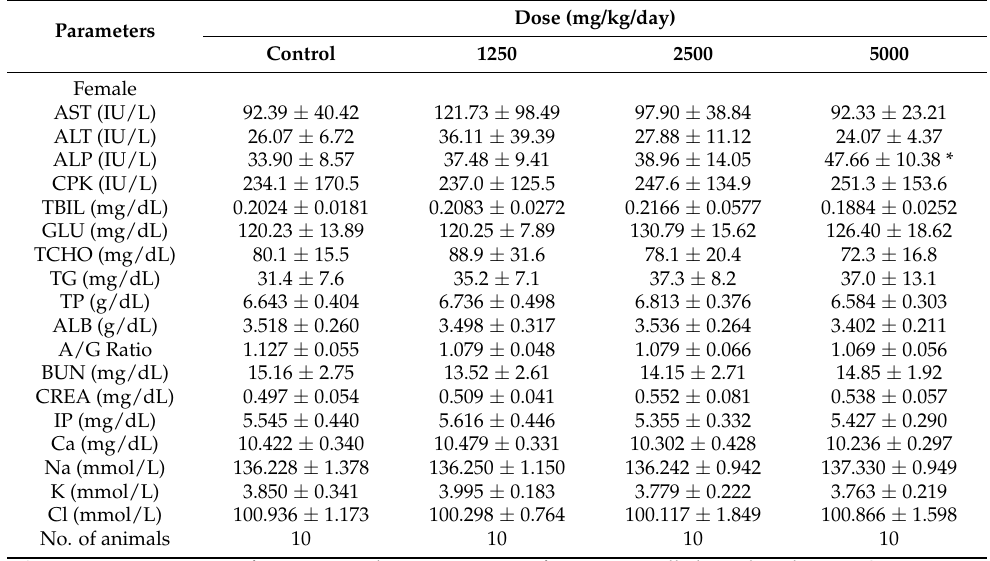
Table 10. Serum biochemical values in 13 weeks repeated oral dose toxicity of WG extract in female rats.